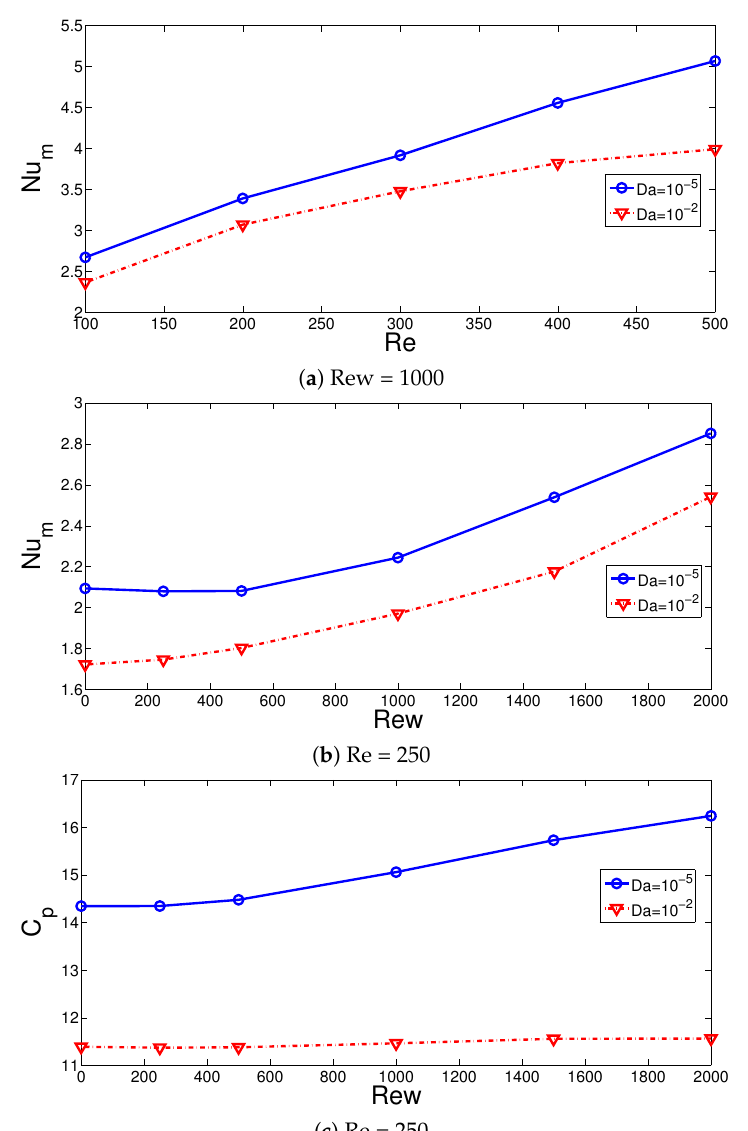
Figure 8. Effects of Re on the average Nu variations at two different permeabilities of the PL ( a ) and effects of Rew on the variation of average Nu ( b ) and pressure coefficient ( c ) (Ha = 7.5, ax = 0.25 ap, N =